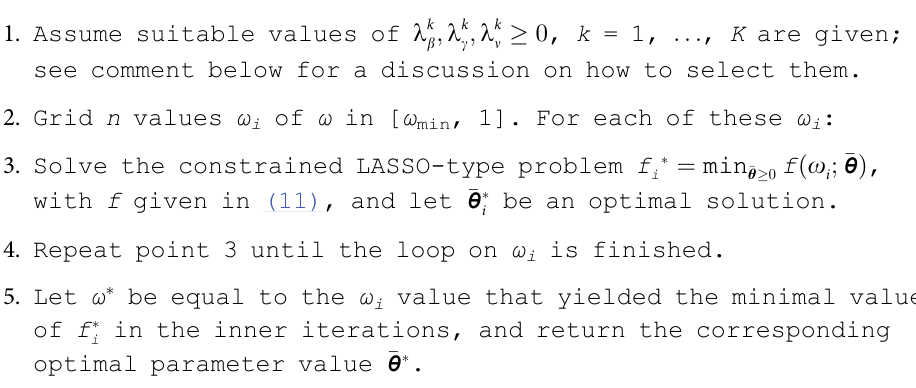
Algorithm 2 ( Estimation of time-varying parameters